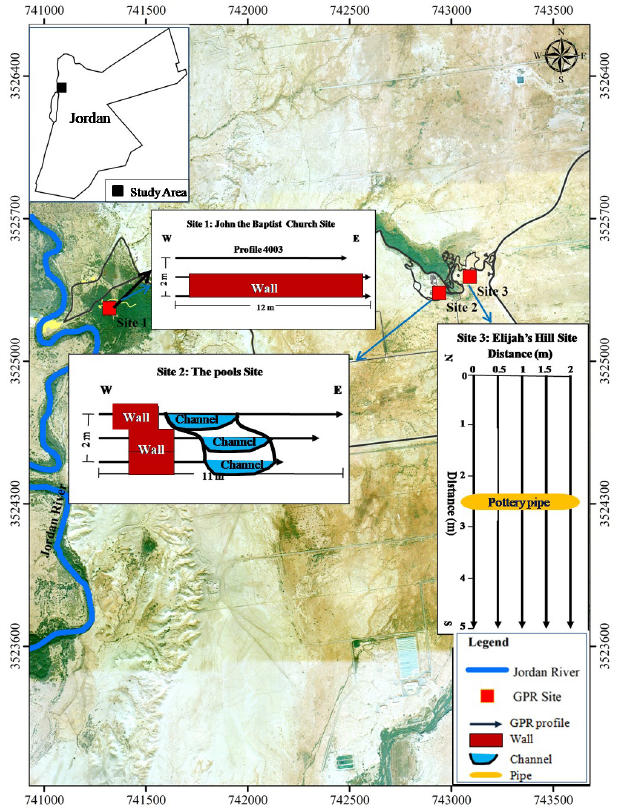
Figure 13. Location map of the inferred archeological material “Af- ter © Google